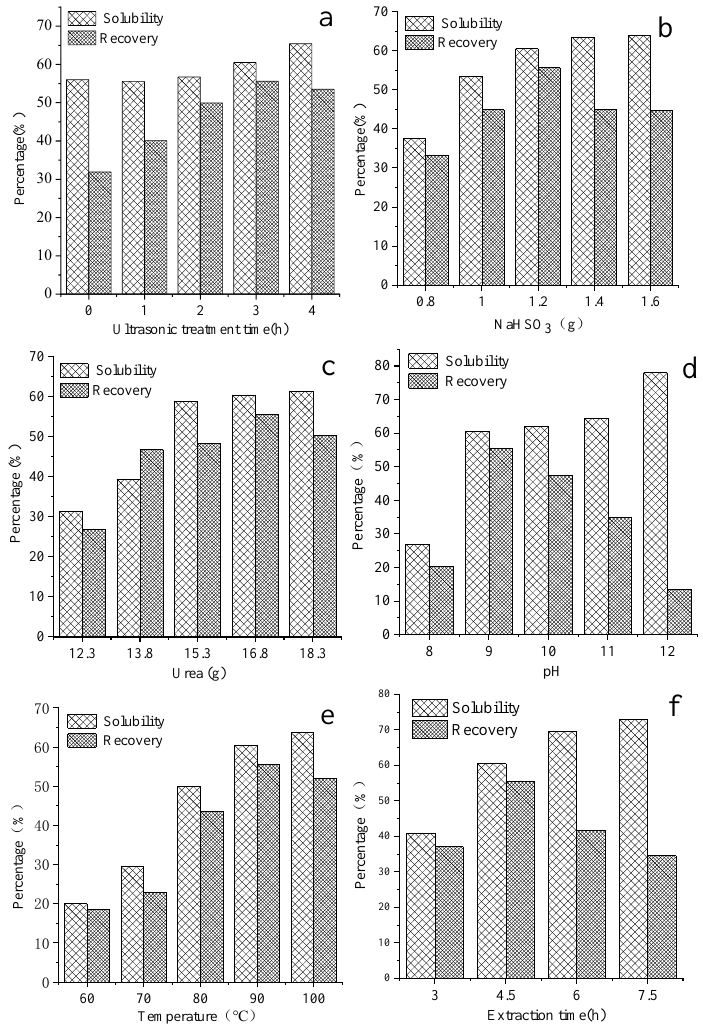
Figure 3. Effect of various factors on the rabbit hair keratin extraction using the ultrasonic-assisted reducing agent-based method: ( a ) Effect of ultrasonic treatment times, ( b ) Effect of sodium bisulfite dose, ( c ) Effect of urea dose, ( d ) Effect of Ph, ( e ) Effect of extraction temperature, and ( f ) Effect of extraction time.